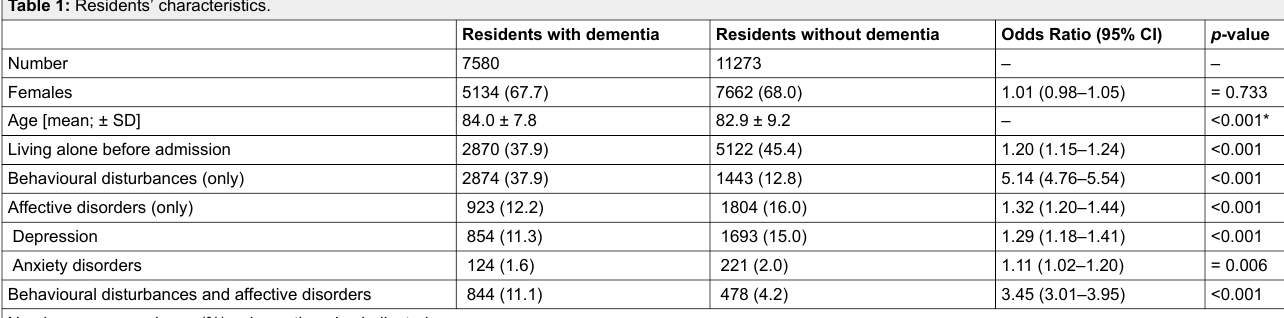
Table 1: Residents’